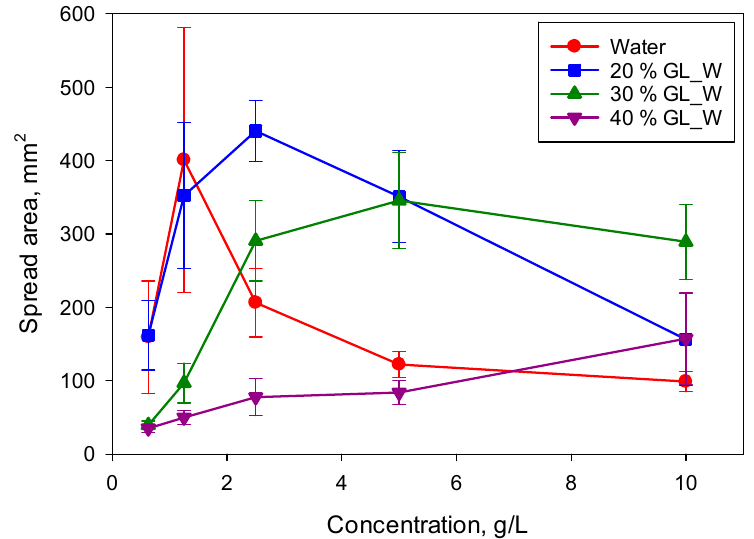
Figure 8. Dependence of the spread area on PE at t = 14 s on concentration of BT-278 in various aqueous solvents.